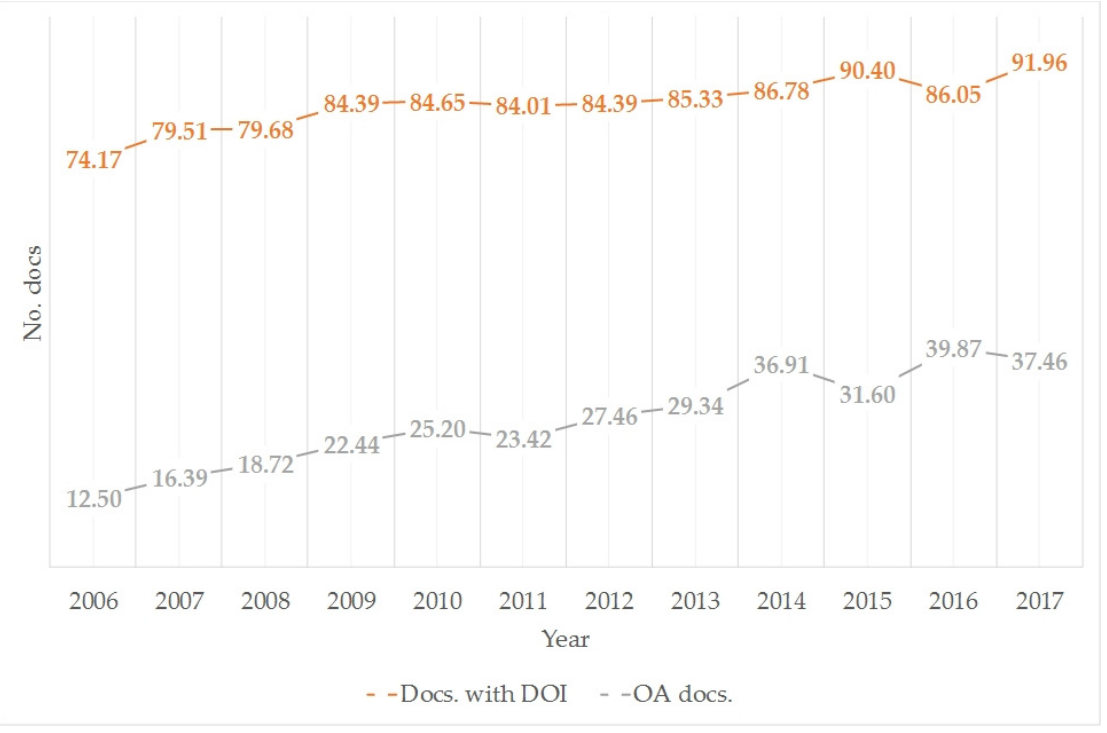
Figure 3. Documents with Digital Object Identifier (DOI) and open access documents, per cent of total by